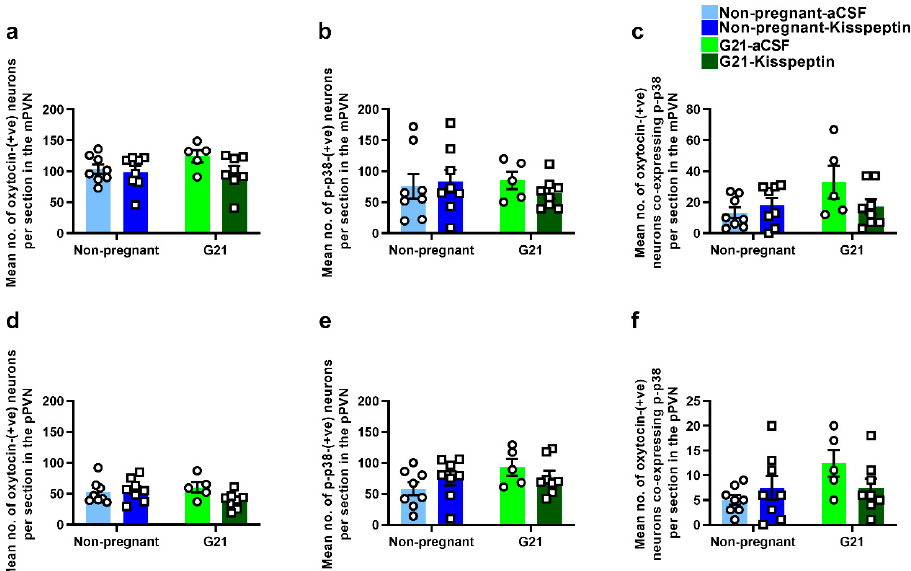
Figure 4. Kisspeptin does not affect p-p38 expression in mPVN or pPVN oxytocin neurons of non- pregnant and G21 rats. Mean ( ± SEM) number of ( a ) oxytocin-positive neurons (RS: F (1,1) = 1.15, p = 0.292; T: F (1,1) = 2.69, p = 0.113; RS × T: F (1,2) = 1.30, p = 0.264, two-way ANOVA), ( b ) p-p38-positive neurons (RS: F (1,1) = 0.083, p = 0.775; T: F (1,1) = 0.145, p = 0.706; RS × T: F (1,2) = 0.726, p = 0.402, two-way ANOVA) and ( c ) oxytocin-positive neurons co-expressing p-p38 (RS: F (1,1) = 2.90, p = 0.100; T: F (1,1) = 0.99, p = 0.32; RS × T: F (1,2) = 3.55, p = 0.071, two-way ANOVA) per section in the mPVN of non-pregnant rats and G21 rats after ICV administration of aCSF/kisspeptin (2 µg in 2 µL). Mean (± SEM) number of ( d ) oxytocin-positive neurons (RS: F (1,1) = 0.527, p = 0.474; T: F (1,1) = 1.74, p = 0.199; RS × T: F (1,2) = 3.58, p = 0.070, two-way ANOVA), ( e ) p-p38-positive neurons (RS: F (1,1) = 2.56, p = 0.122; T: F (1,1) = 0.001, p = 0.967; RS × T: F (1,2) = 2.06, p = 0.163. two-way ANOVA) and ( f ) oxytocin-positive neurons